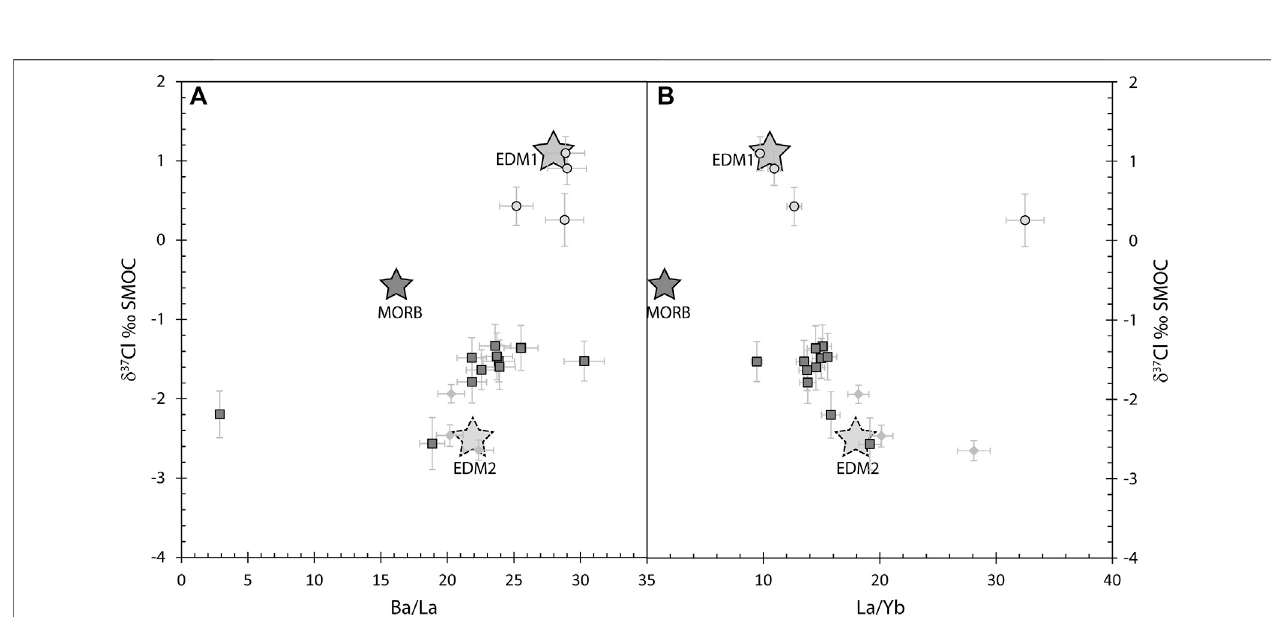
FIGURE 9 | Chlorine isotopes compared to (A) Cl content in melt inclusions and (B) S/Cl in melt inclusions and gases ([2]: Liotta et al., 2017). (A) For comparison, bulk rocks from Stromboli ([2]: Liotta et al., 2017)are plotted, aswell astheolivine-hostedmelt inclusionsfrom [1]:Manziniet al.(2017).Meltinclusionsare allenriched in Cl compared to bulk rocks. Overall, no relationship between Cl and δ 37 Cl can be seen. (B) Melt inclusions have similar δ 37 Cl to Stromboli gases. As for the gases, a positive correlation can be seen between δ 37 Cl and S/Cl, which cannot be linked to S or Cl degassing.